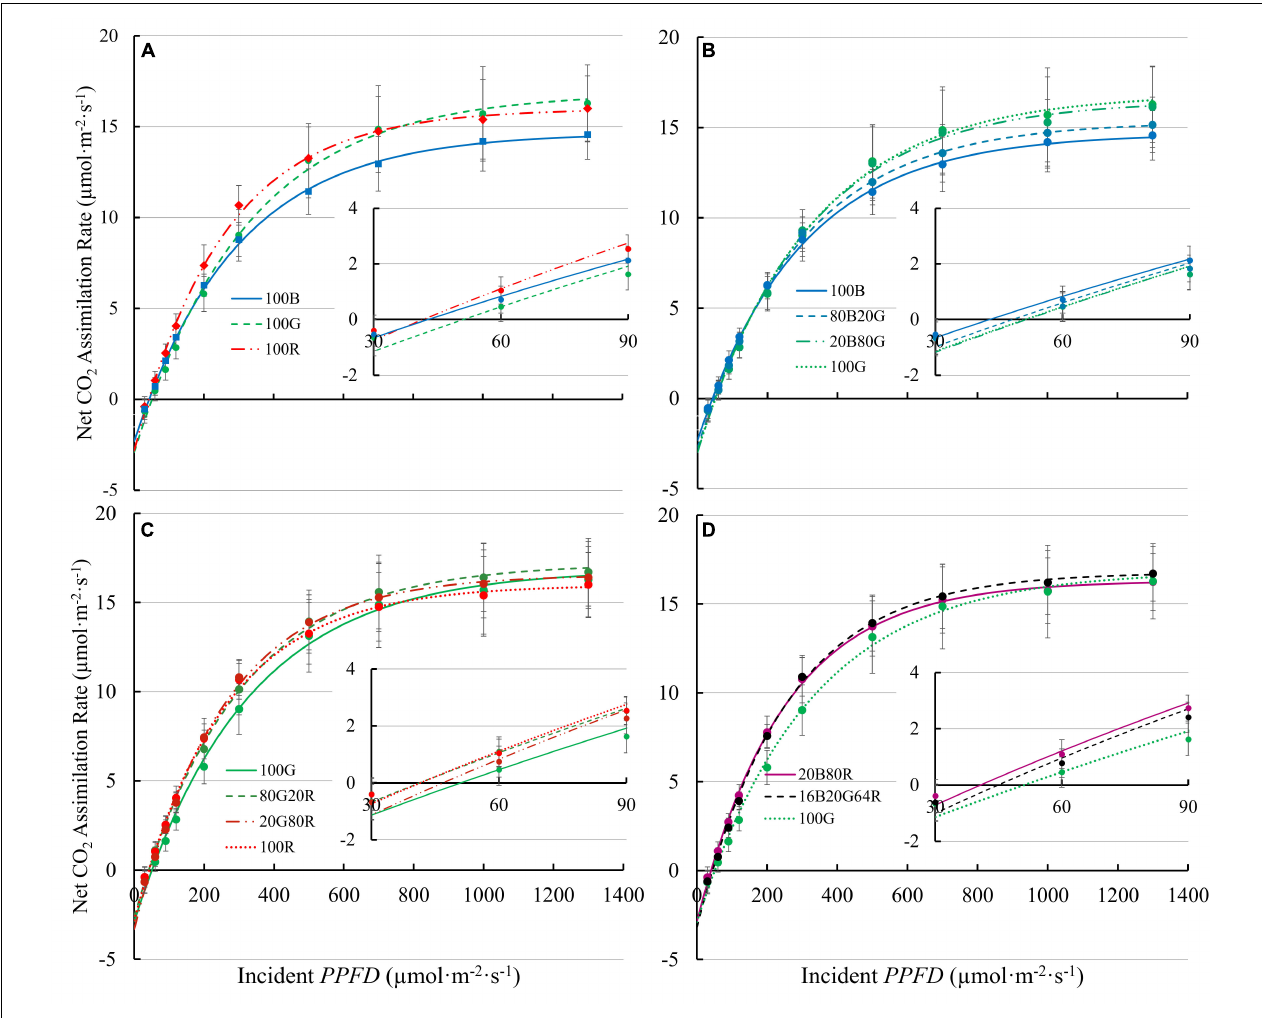
FIGURE 3 | Net assimilation ( A n ) – light response curves of “Green Towers” lettuce under nine light spectra. Error bars represent the standard deviation ( n = 9). Inserts show A n against PPFD of 30-90 µ mol · m − 2 · s − 1 s to better show the initial slopes of curves. The composition of the nine light spectra is shown in Table 1 . The light spectra in the graphs are (A) 100B, 100G, and 100R; (B) 100B, 80B20G, 20B80G, and 100G; (C) 100G, 80G20R, 20G80R, and 100R; and (D) 20B80R, 16B20G64R, and